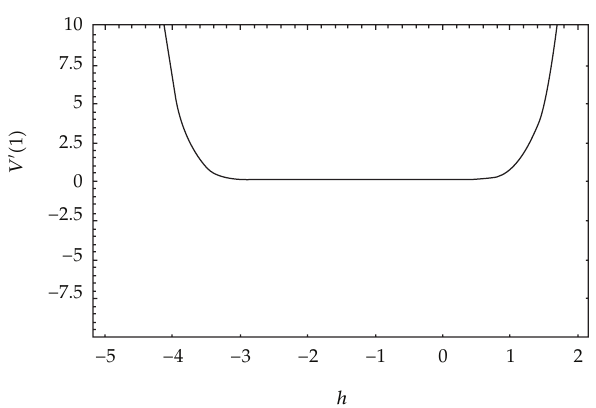
Figure 4: ħ -curve for velocity in case of variable viscosity at 10th-order approximation.